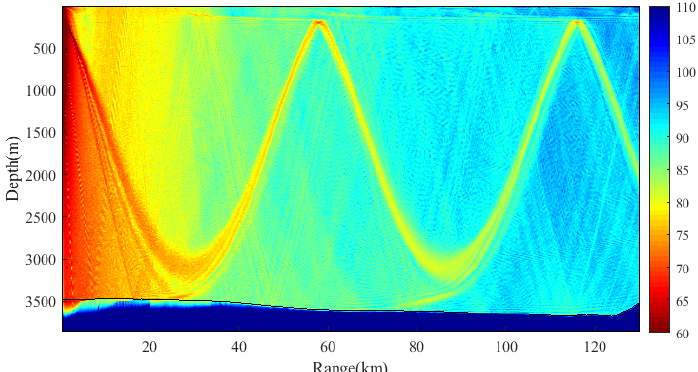
Figure 14. Simulated TLs for the SSP in the EIO and water depth in the SCS.